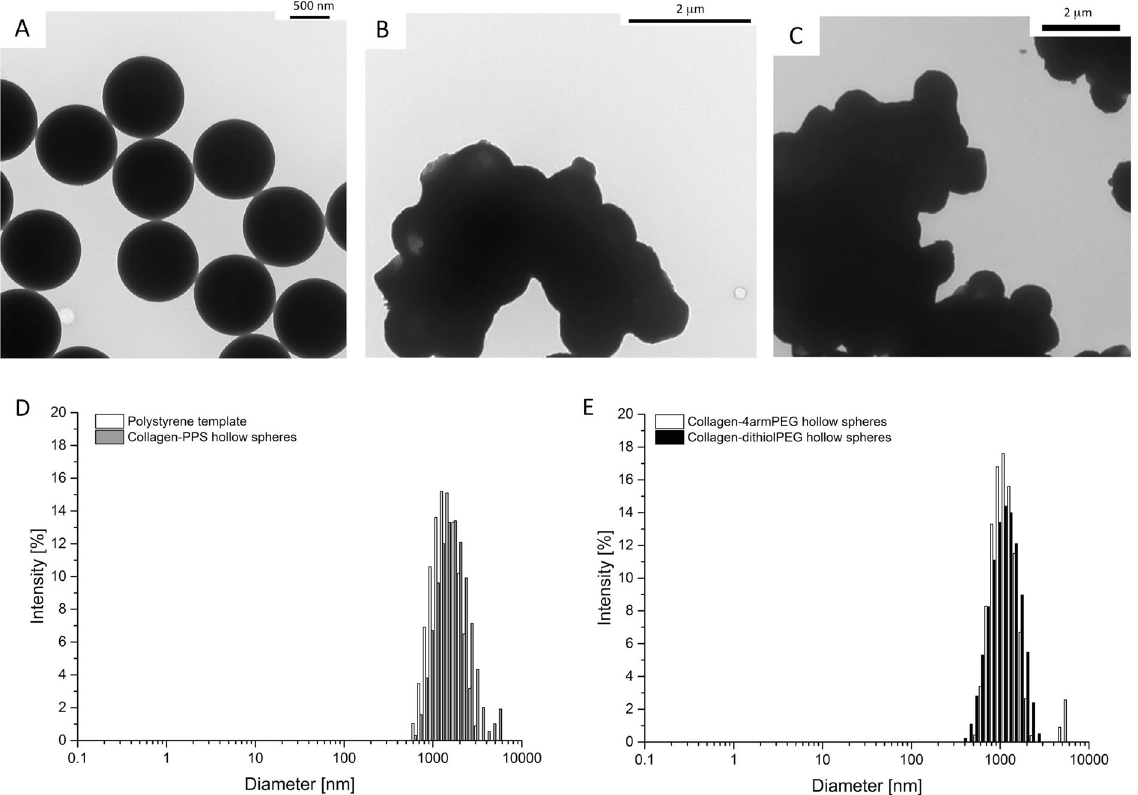
Figure 2. Hollow spheres TEM imaging and DLS analysis. ( A ) 1 μ m polystyrene templates, ( B ) mixed collagen- PPS hollow spheres, ( C ) mixed collagen-4armPEG hollow spheres (control). ( D ) DLS plots of size distribution for the 1 μ m polystyrene templates and mixed collagen-PPS hollow spheres, E) DLS plots of size distribution